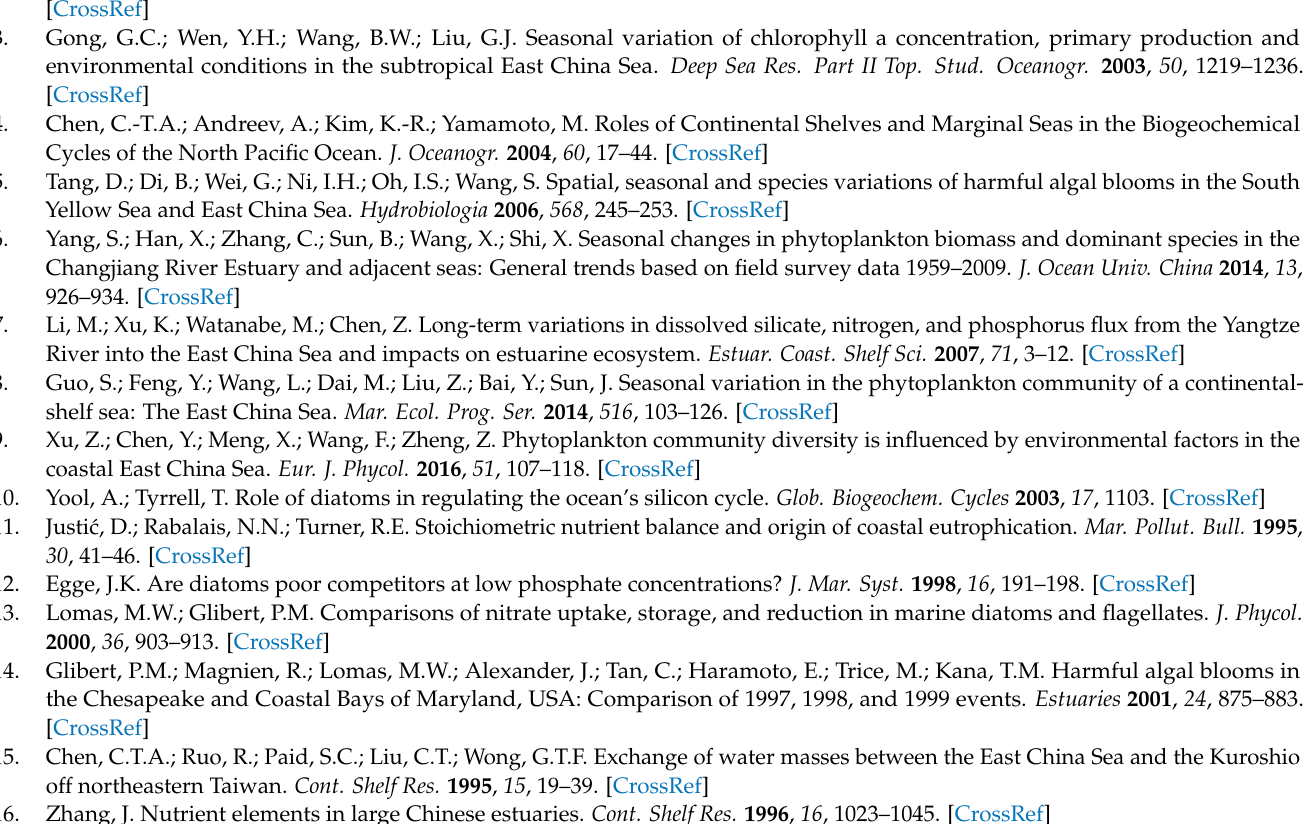
Table S2: Deposition fluxes ( µ mol m − 2 day − 1 ) of major aerosol components in the aerosol samples in the spring months from year 2011 to 2015, Table S3: Correlations between Chl a concentration and dry fluxes of major atmospheric components considering time lags from 0 to 5 days in the larger sea area of